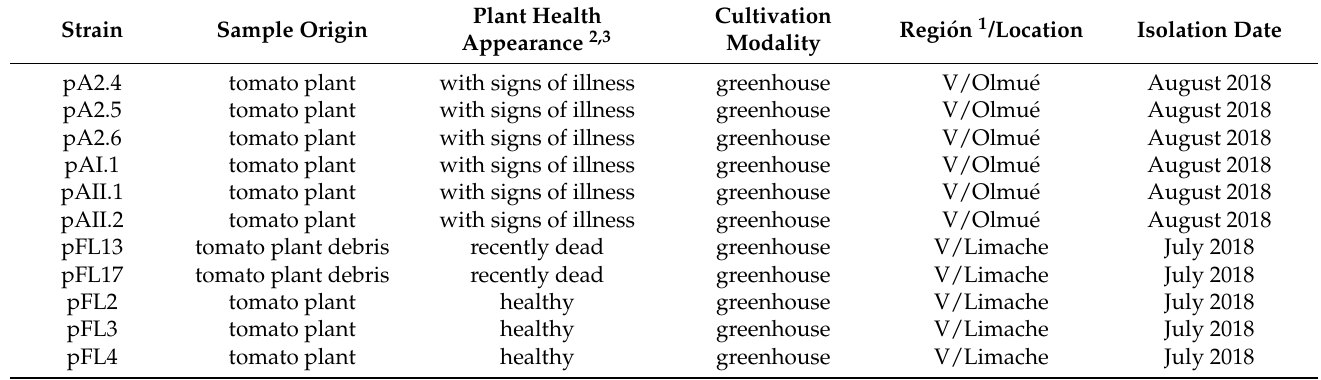
Figure 1. Geographical distribution map of sampling locations for Pseudomonas isolates in Chile. On the right, the central zone of the country is enlarged, and the four regions (Valparaíso, O´Higgins, Maule, and Bío Bío) show where sampled tomato-producing orchards were found. Colored points show locations of the sampled orchards inside each region. Table 1. Bacterial species most closely related to Pseudomonas spp. isolates based on identity of 16S rRNA gene sequences.